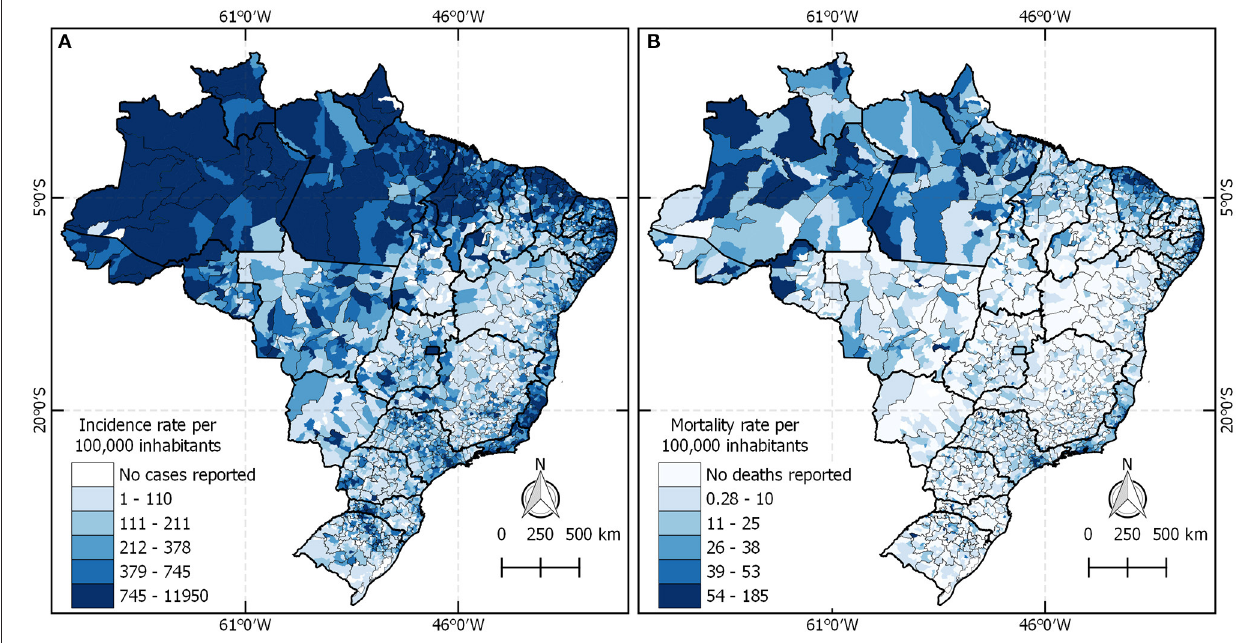
FIGURE 2 | The COVID-19 incidence and mortality rate in